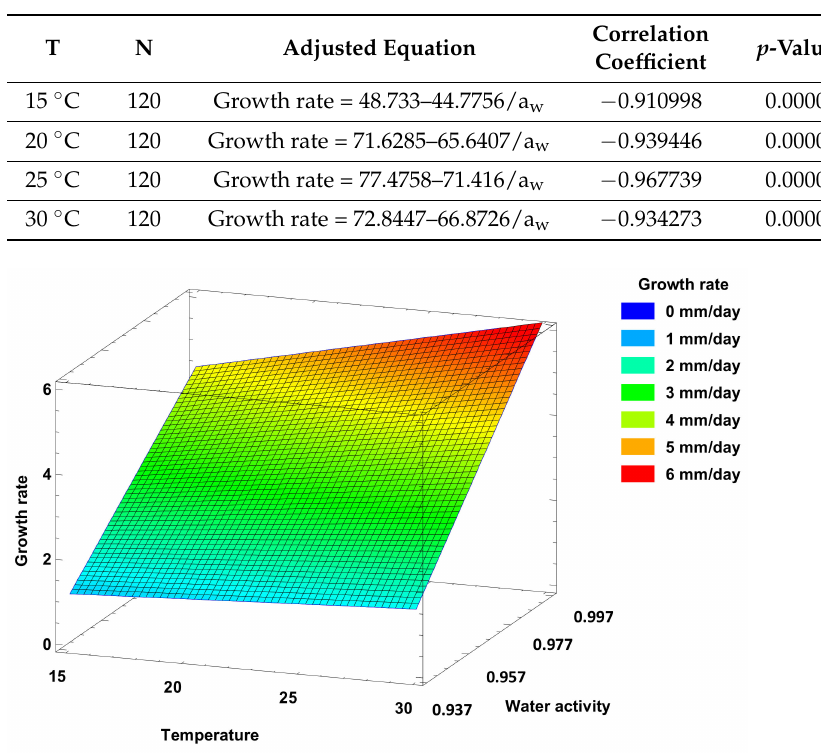
Figure 5. Surface contour plot of growth rate responses at varying temperatures and water